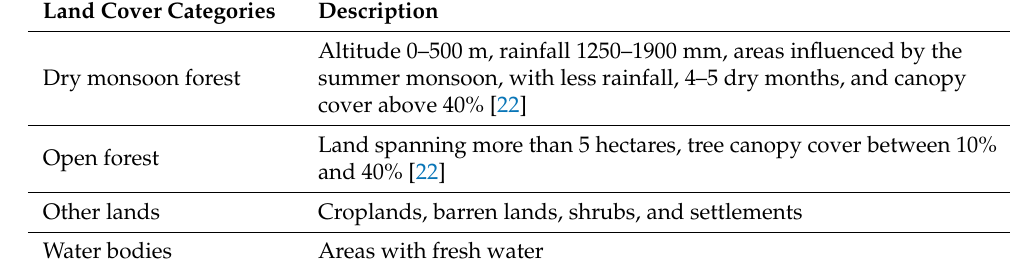
Table 1. Description of land cover categories.